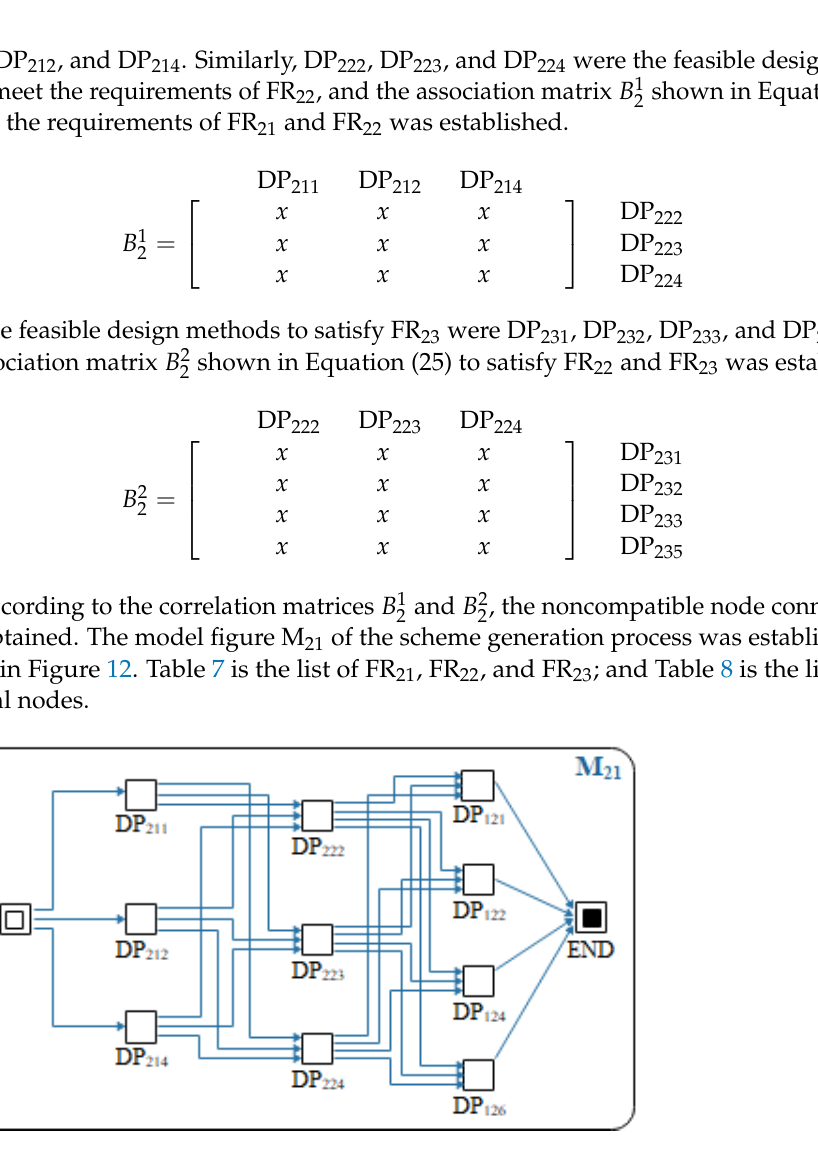
Figure 12. Schematic generation process diagram of FR 21 , FR 22 , and FR 23 . Table 7. List of FR 21 , FR 22 , and FR 23 . Source of Function Requirements (FR S )